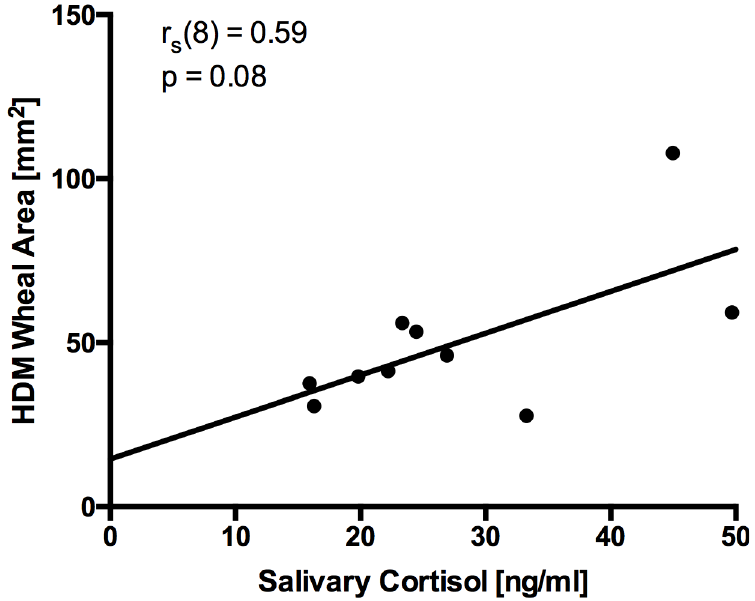
Fig 4. Spearman’s correlation analysis between HDM wheal area [mm 2 ] and the salivary cortisol (ng/ml) Post- TSST. The solid line is a linear fit to the data with the Spearman correlation coefficient of r s = 0.59.